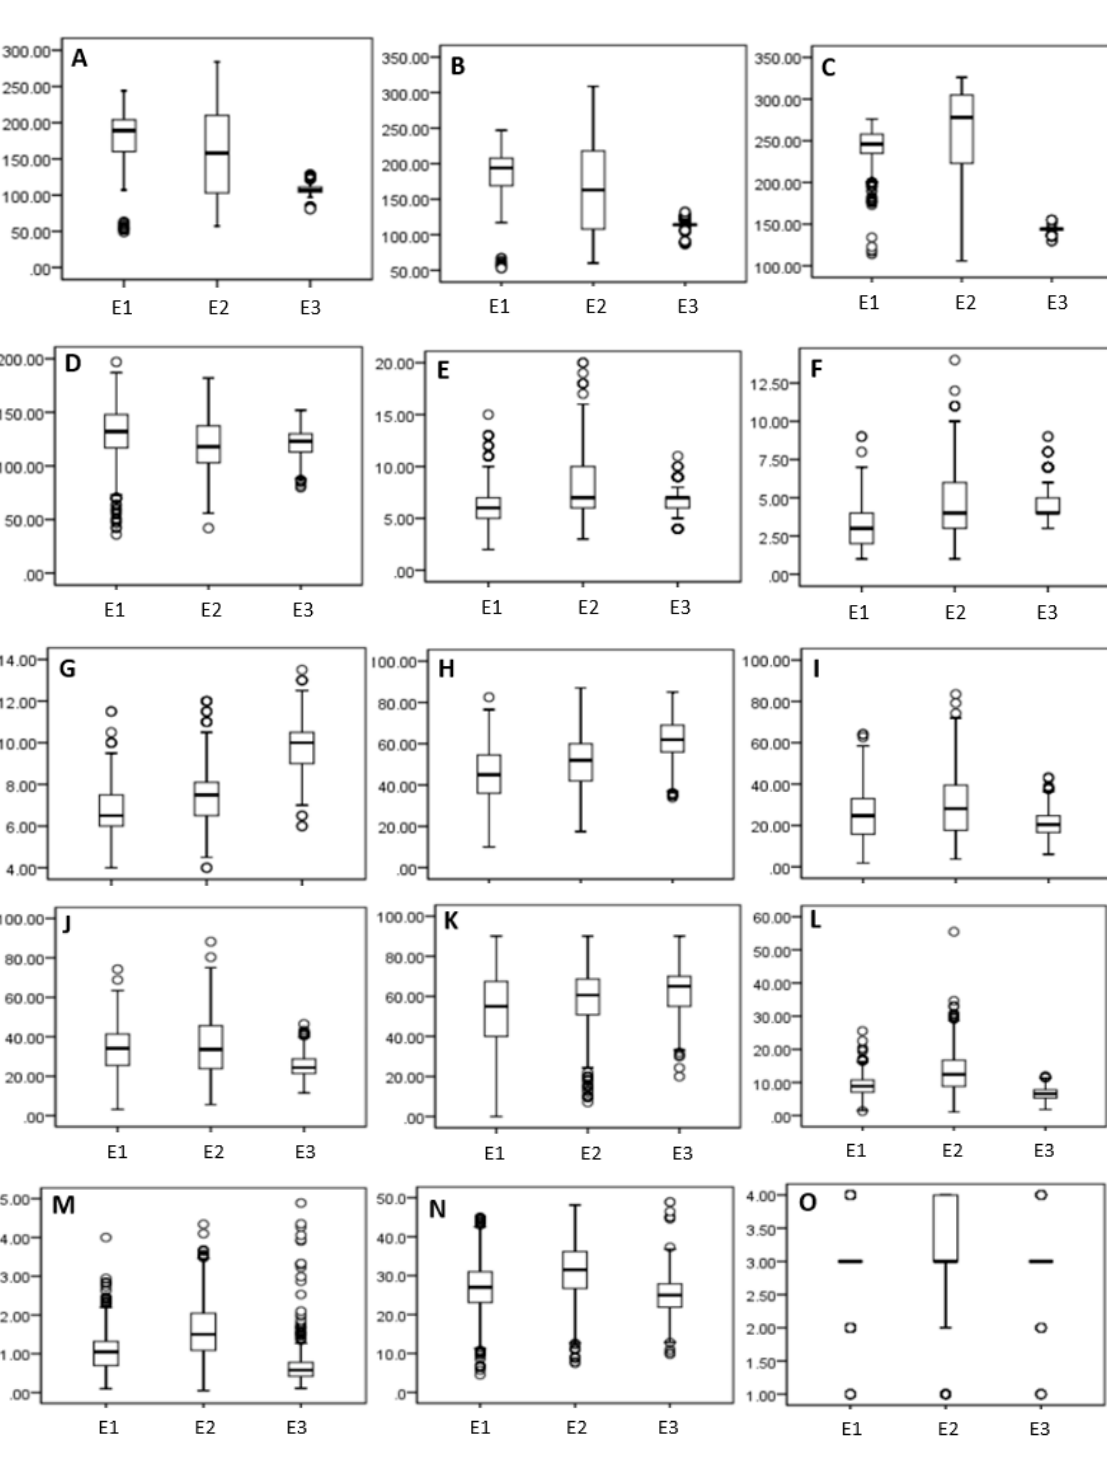
Figure 1. Box plot of the distributions of some aboveground traits including ( A ) heading time, HT (in days); ( B ) flowering time, FT (in days); ( C ) maturity time, MT (in days); ( D ) plant height, PH (in cm); ( E ) total tiller number, TTN; ( F ) effective tiller number, ETN; ( G ) spike length, SpL (in cm); ( H ) peduncle length, PL (in cm); ( I ) flag leaf area, FLA (in cm 2 ); ( J ) second leaf area, SLA (in cm 2 ); ( K ) shoot angle, SAng (in degrees); ( L ) biomass/plant, BPP (in gm); ( M ) yield/plant, YPP (in gm); ( N ) thousand kernel weight, TKW (in gm); and ( O ) threshability, T (scored on a 1–4 scale; 1 = completely free-threshing and 4 = difficult to thresh). E1, E2, and E3 on X axis represent three experimental environments as detailed in the Materials and Methods section.